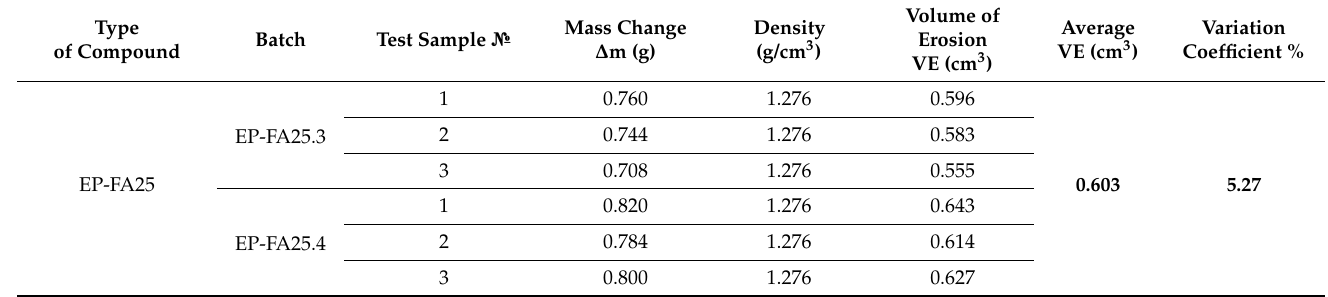
Table A10. Wear of filled epoxy binder (EP-FA25) at 100 ◦ C at an impingement angle of 45 ◦ .